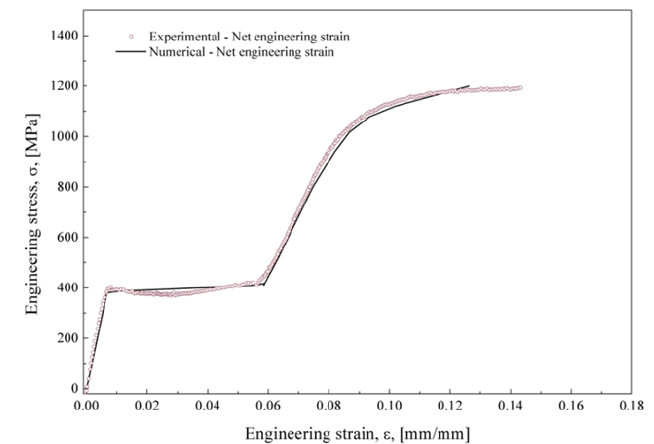
Figure 6: Comparison between experimentally measured stress-strain curve and numerically simulated